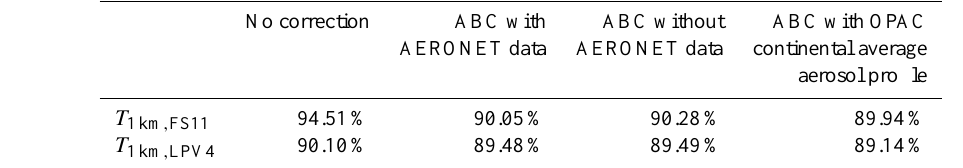
Table 1. Average transmittance for 1km slant range before and after ABC (for spectrum 250–4000nm).